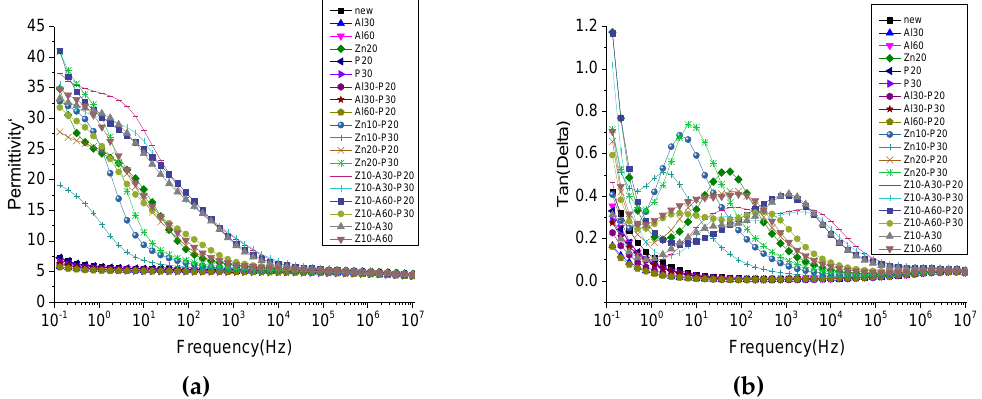
Figure 12. Frequency dielectric spectrum ( a ) and dielectric loss spectra ( b ) of the insulating pressboard with different films.